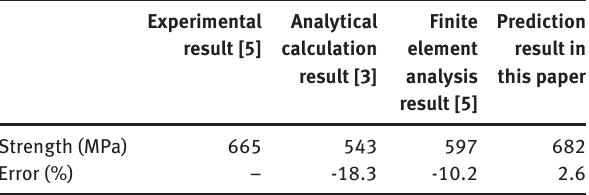
Table 1: Theoretical prediction results and errors of the 3D four- directional braided carbon fiber/resin matrix composite.